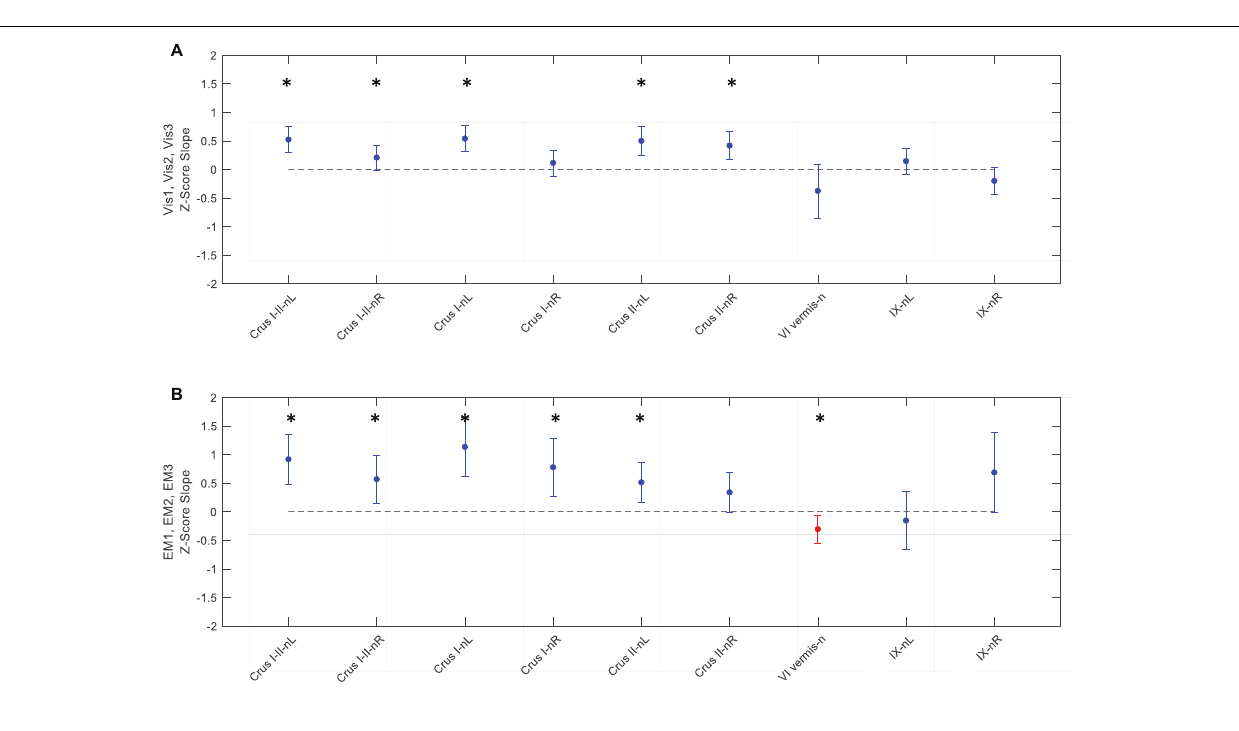
Frontiers in Systems Neuroscience | www.frontiersin.org